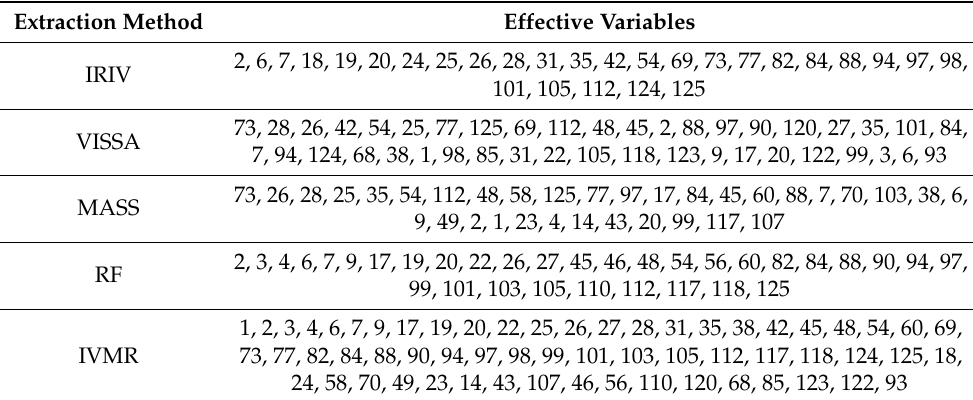
Table 3. Effective variables extracted by different methods.